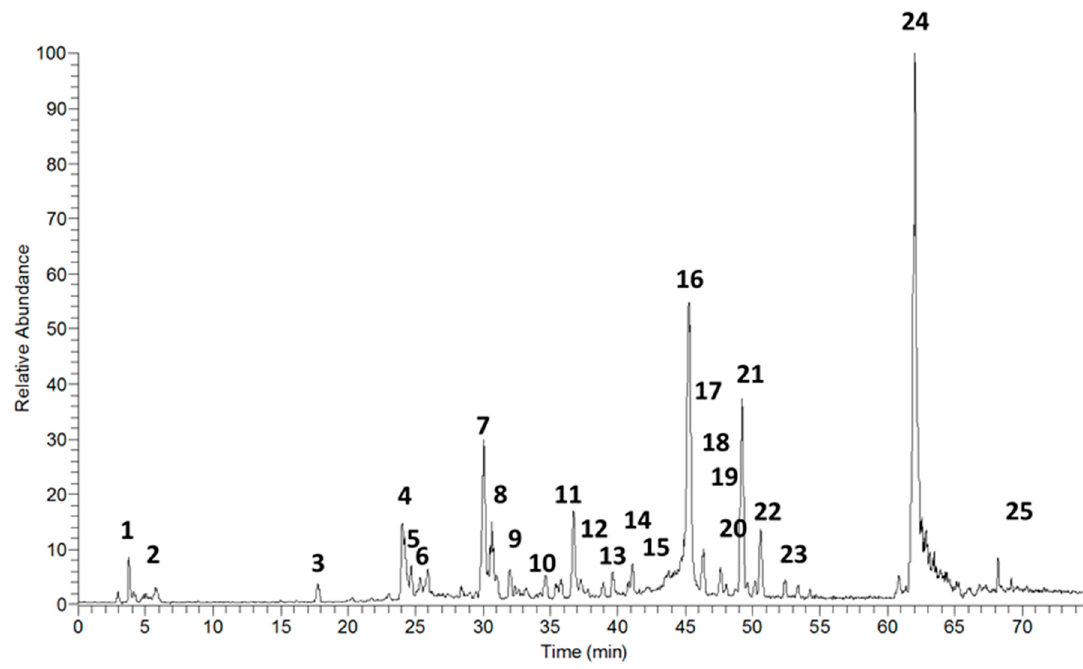
Figure 11. Chromatogram of total ions obtained by HPLC-PDA-ESI-IT-MS/MS, positive mode, from the hydroethanolic extract of A. chica the hydroethanolic extract of A. chica leaves.